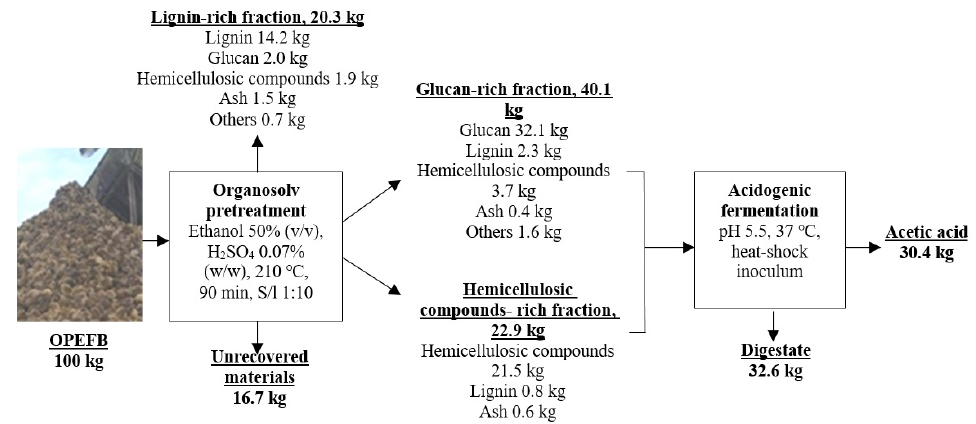
Figure 3. Mass balance on OPEFB biorefinery concept to produce lignin and acetic acid. From 100 kg OPEFB (dry basis), 38.5 kg of glucan-rich fraction and 22.9 kg of hemi- cellulosic compounds-rich fraction were obtained [16]. The total solid was 63.0 kg (in- cluding lignin and ash). According to Table 1, the VS content of the mixed fraction was 96.55 ± 0.05%. Hence, volatile solid (VS) was assumed as the total amount of organic materials from the pretreated OPEFB. Using the VS value, the number of organic materials in the